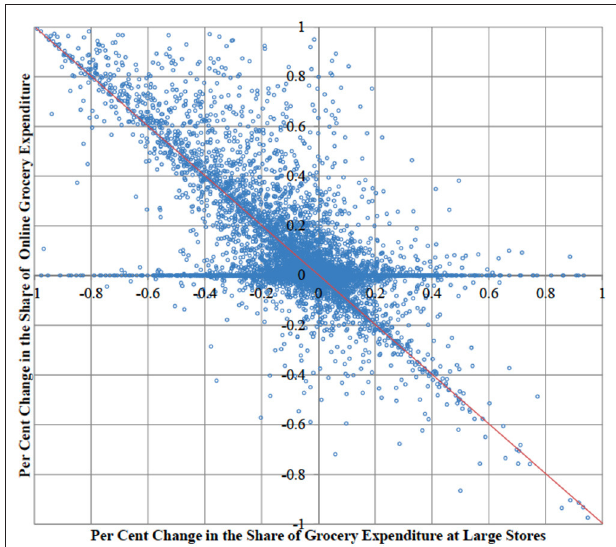
FIGURE 4 | Plot of per cent changes in household grocery expenditure at large stores and online before and after Covid-19 outbreak (UK, data are individual